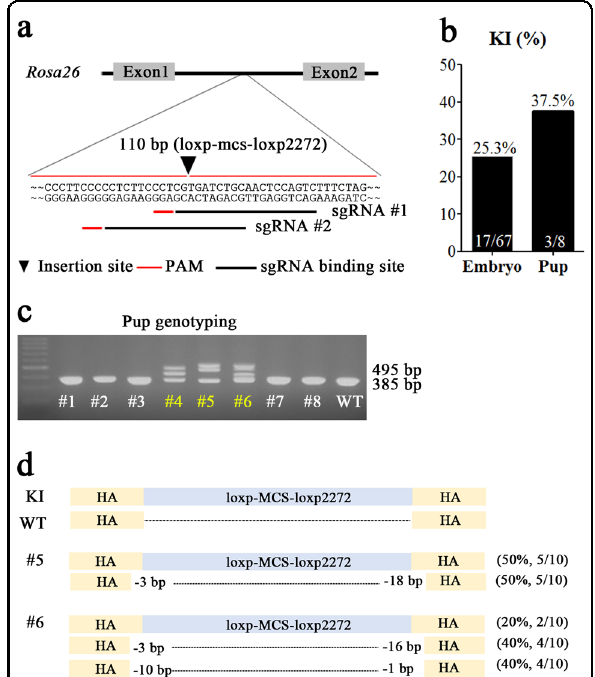
Fig. 1 Overlapping sgRNAs mediate KI of ssODN-containing loxP - mcs- loxP 2272 sequences at the mouse Rosa26 locus. a Schematic diagram of the strategy for precise KI of the ssODN including 45-nt homology arms (green bars) and a 110-nt insertion consisting of 34 nt of the loxP sequence, 34 nt of the loxP 2272 sequence, and a multiple cloning site (MCS) into intron 1 of the Rosa26 locus. b After microinjection of overlapping sgRNAs, Cas9 mRNA, and ssODNs, PCR- based ssODN-mediated KI ef fi ciency was measured and is represented as bar graphs. KI (%) indicates the ratio of KI embryos derived from total blastocysts or KI pups from total pups born. c PCR-based genotyping of pups using speci fi c primers (wild type, 385 bp; KI, 495 bp). d Summary of the sequencing results from founder pups. The frequencies of each sequence (black letters) are shown as numbers of KI clones over the total examined